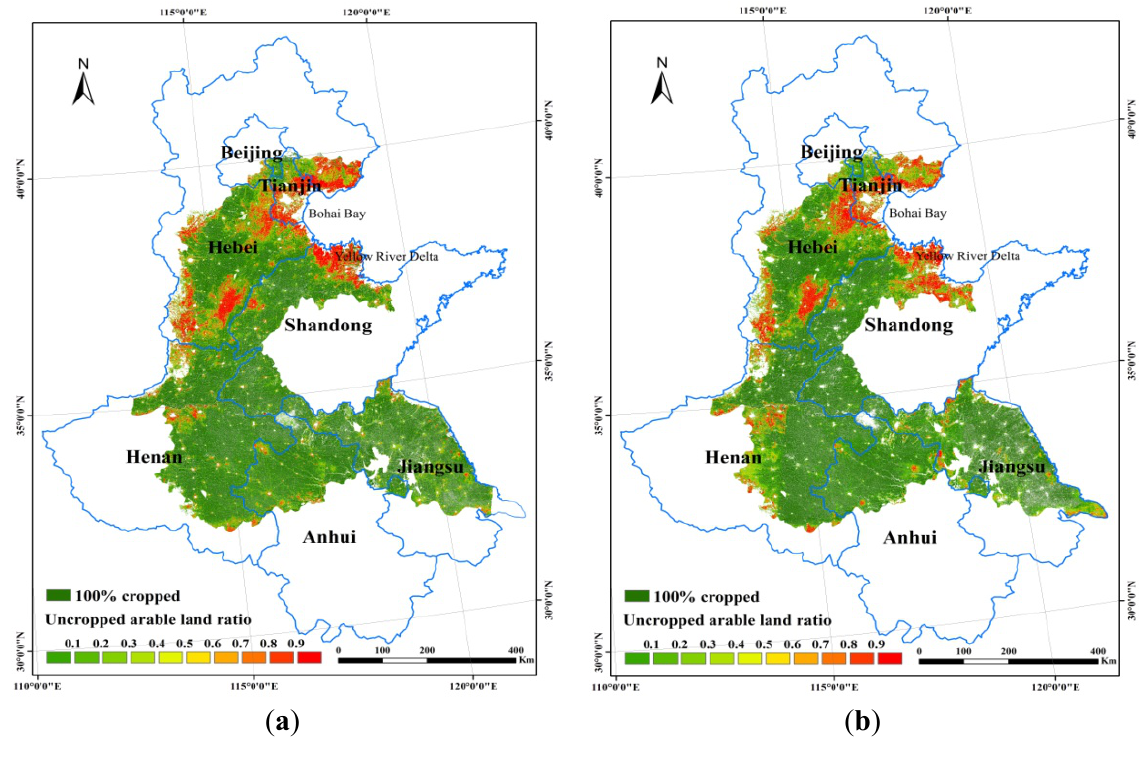
Figure 5. Uncropped arable land ratio (UALR) map for the winter crop growing season in NCP in 2010 (a) and 2011 (b)